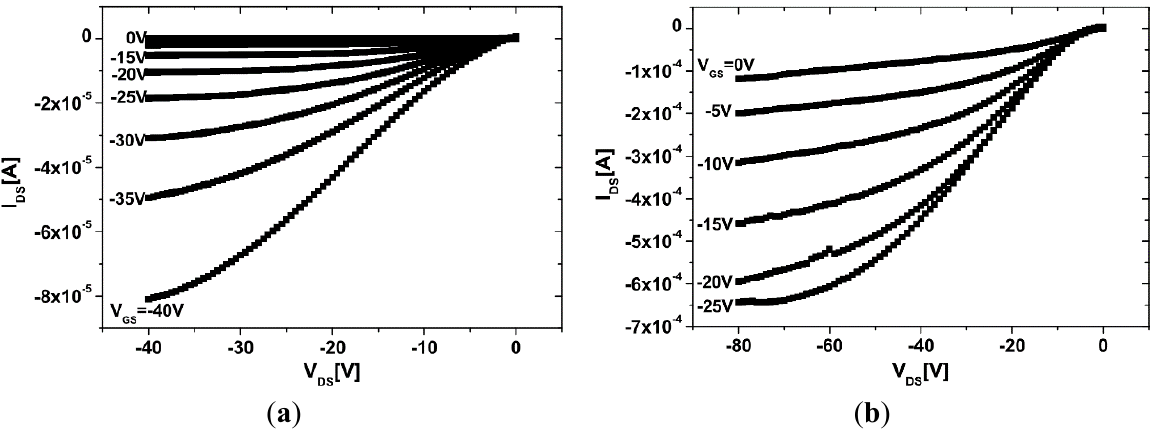
Figure 6. Output characteristics of an inverted coplanar pentacene OTFT using SiO 2 as gate dielectric (L = 1 μ m, W = 1000 μ m). ( a ) Without oxygen plasma treatment (t ox = 150 nm); ( b ) with oxygen plasma treatment in a parallel-plate reactor (t ox = 100 nm). Reprinted from [47], with permission from John Wiley and